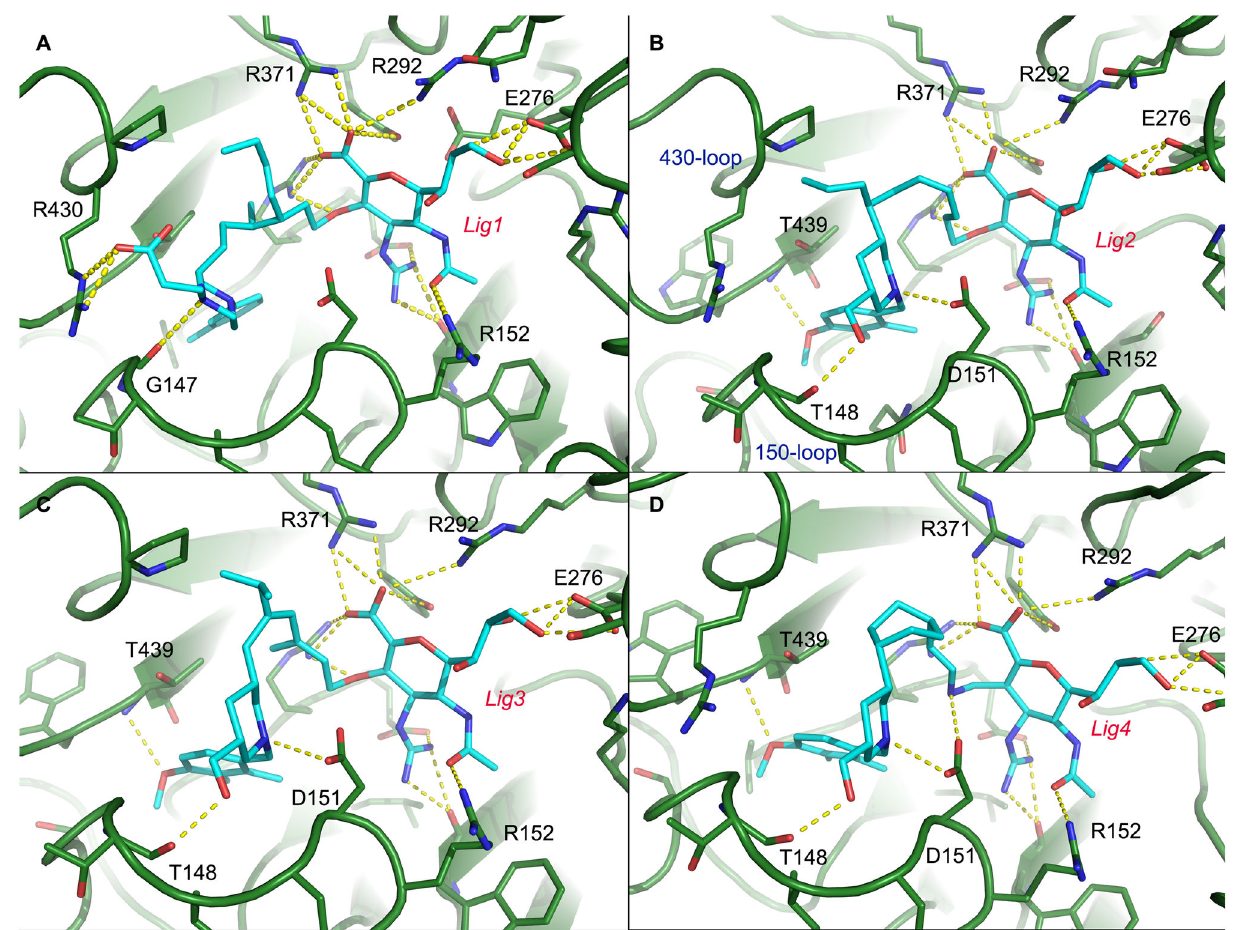
Figure 5. Illustration of the interaction patterns of the linked molecules with 09N1. The proposed binding poses between Lig 1-4 with 09N1 are shown in panels A-D, respectively. All polar contacts are shown as yellow dashed line. doi: